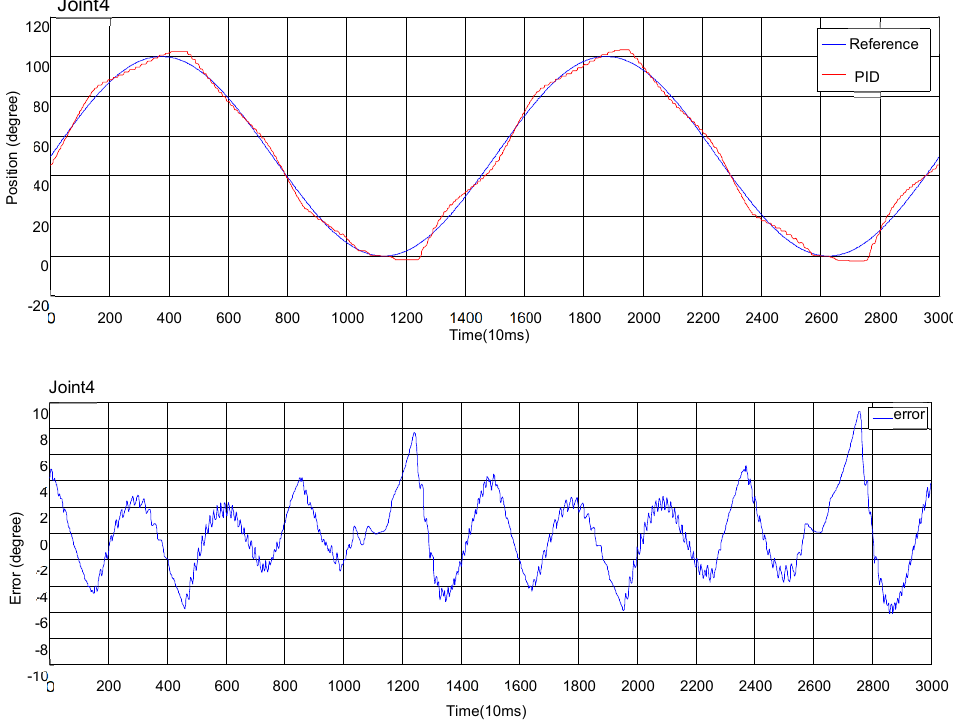
Figure 9. Tracking and error diagrams of PID simulation parameters applied to real system.